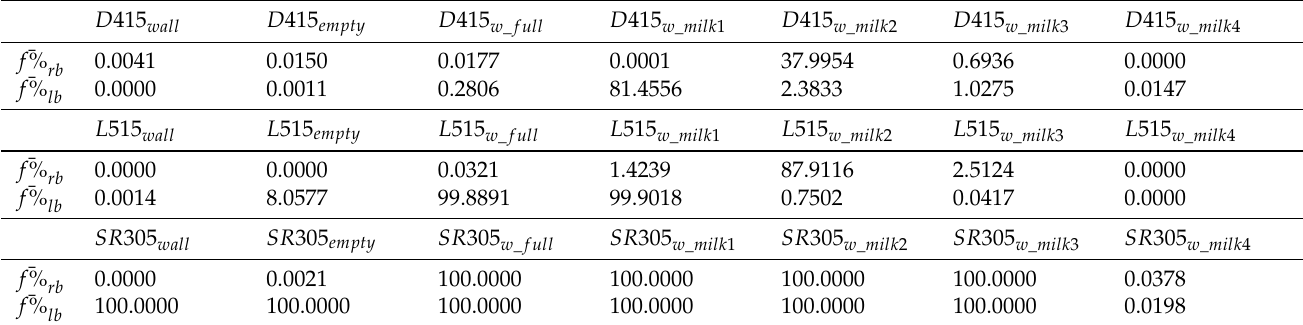
Table 3. Average percentage of invalid points for the right band and left band